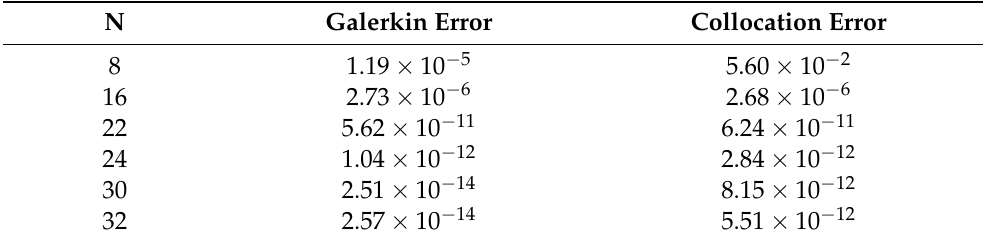
Table 1. The error of the results calculated by the Chebyshev–Galerkin and Chebyshev–collocation spectral methods varies with the truncation order N .